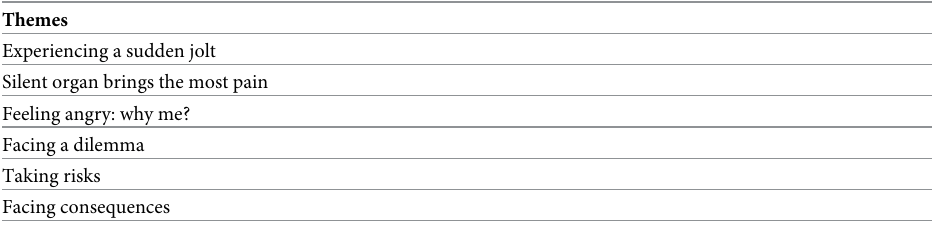
Table 3. Six major themes identified in the